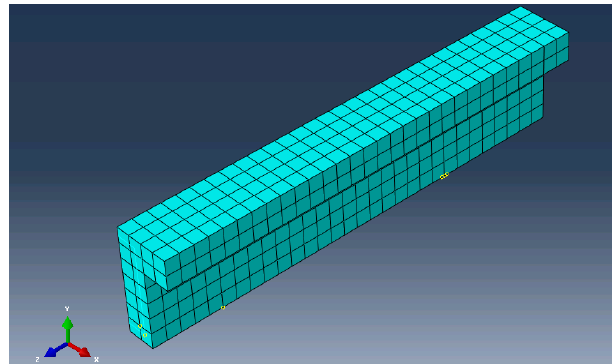
Figure 11. Quarter model of the control beam as modelled in Abaqus.